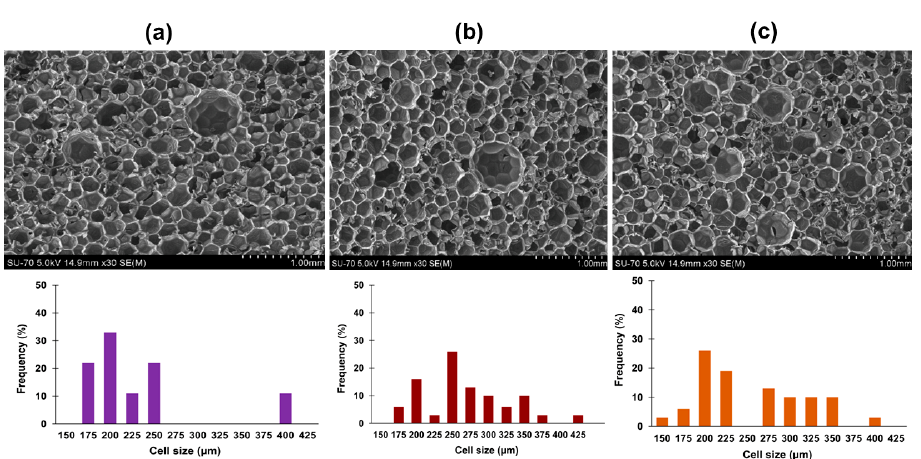
Figure 2. SEM micrographs and cell size distribution in RPUF-1 ( a ), RPUF-6 ( b ), and RPUF-11 ( c ). Free ascent direction and a 30× magnification were used.